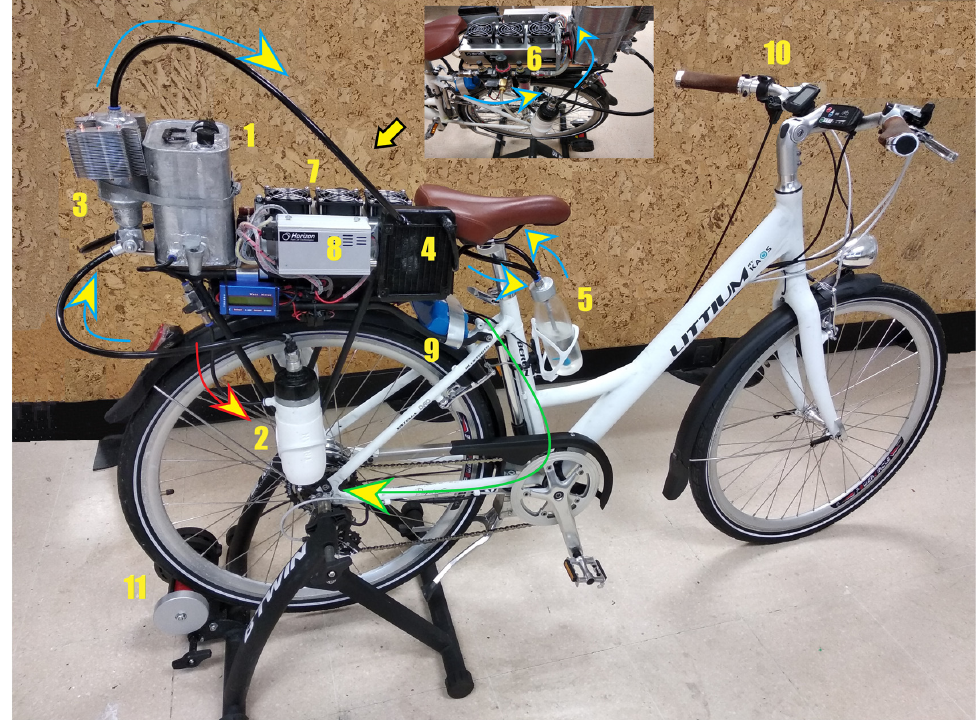
Figure 2. First prototype, with the elements involved in the generation of hydrogen.